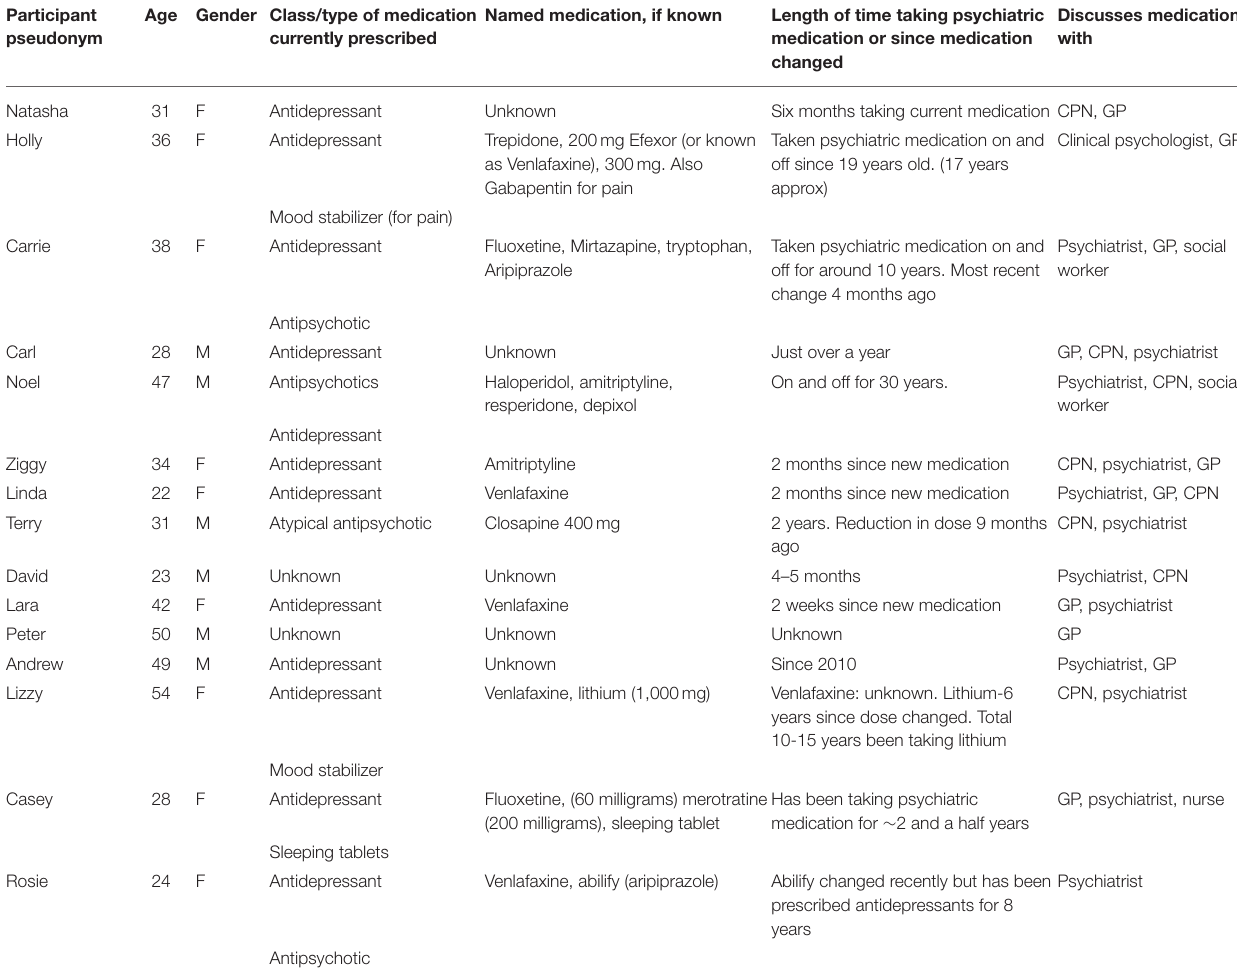
TABLE 1 | Service user participant characteristics. Participant